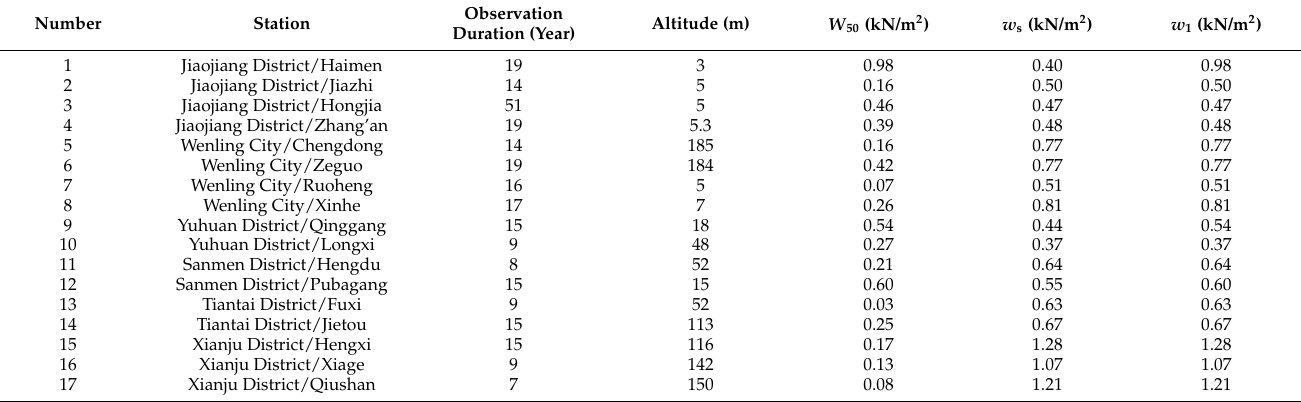
Table 9. Comparison of the simulated design wind pressure at the 17 meteorological stations in